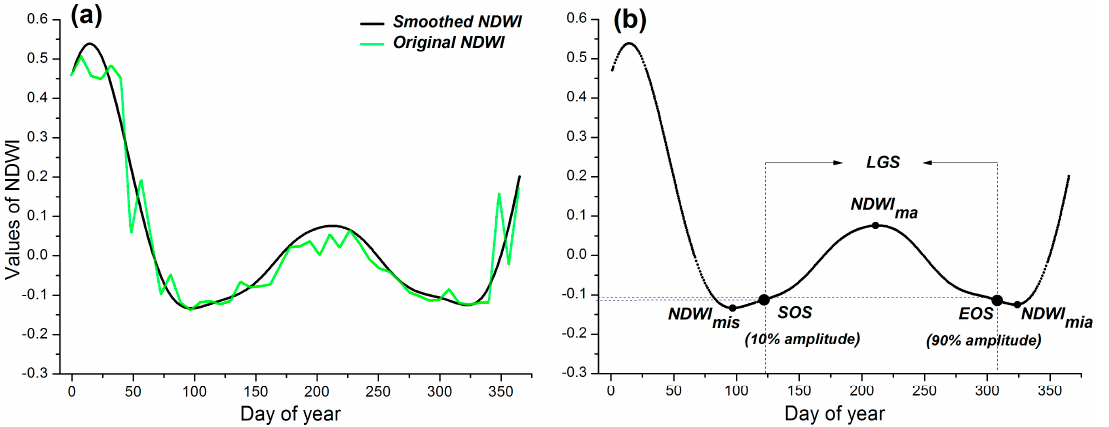
Figure 3. ( a ) Original and smoothed NDWI time series; ( b ) an example of detecting phenology from NDWI time series.